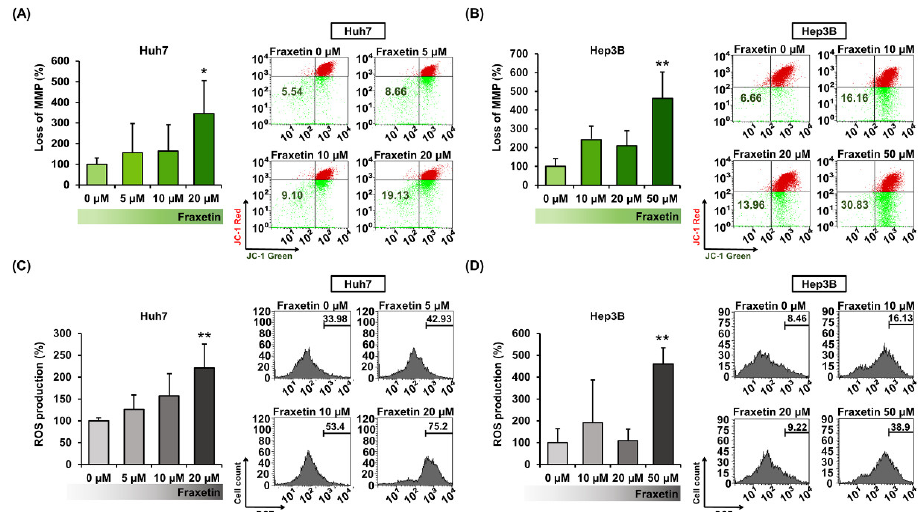
Figure 3. Effects of fraxetin on the mitochondrial function of hepatocellular carcinoma (HCC) cells. ( A , B ) Mitochondrial membrane potential (ΔΨm). Huh7 and Hep3B cells. The amounts of cells in the lower right quadrants are represented as a percentage-ratio in the bar graphs. ( C , D ) Reactive oxygen species (ROS) in Huh7 and Hep3B cells. The right part of peaks was measured and the values are represented as a percentage-ratio in the bar graphs. Asterisks indicate the significance levels of comparisons between vehicle-treated cells and fraxetin-treated cells (* p < 0.05 and ** p <